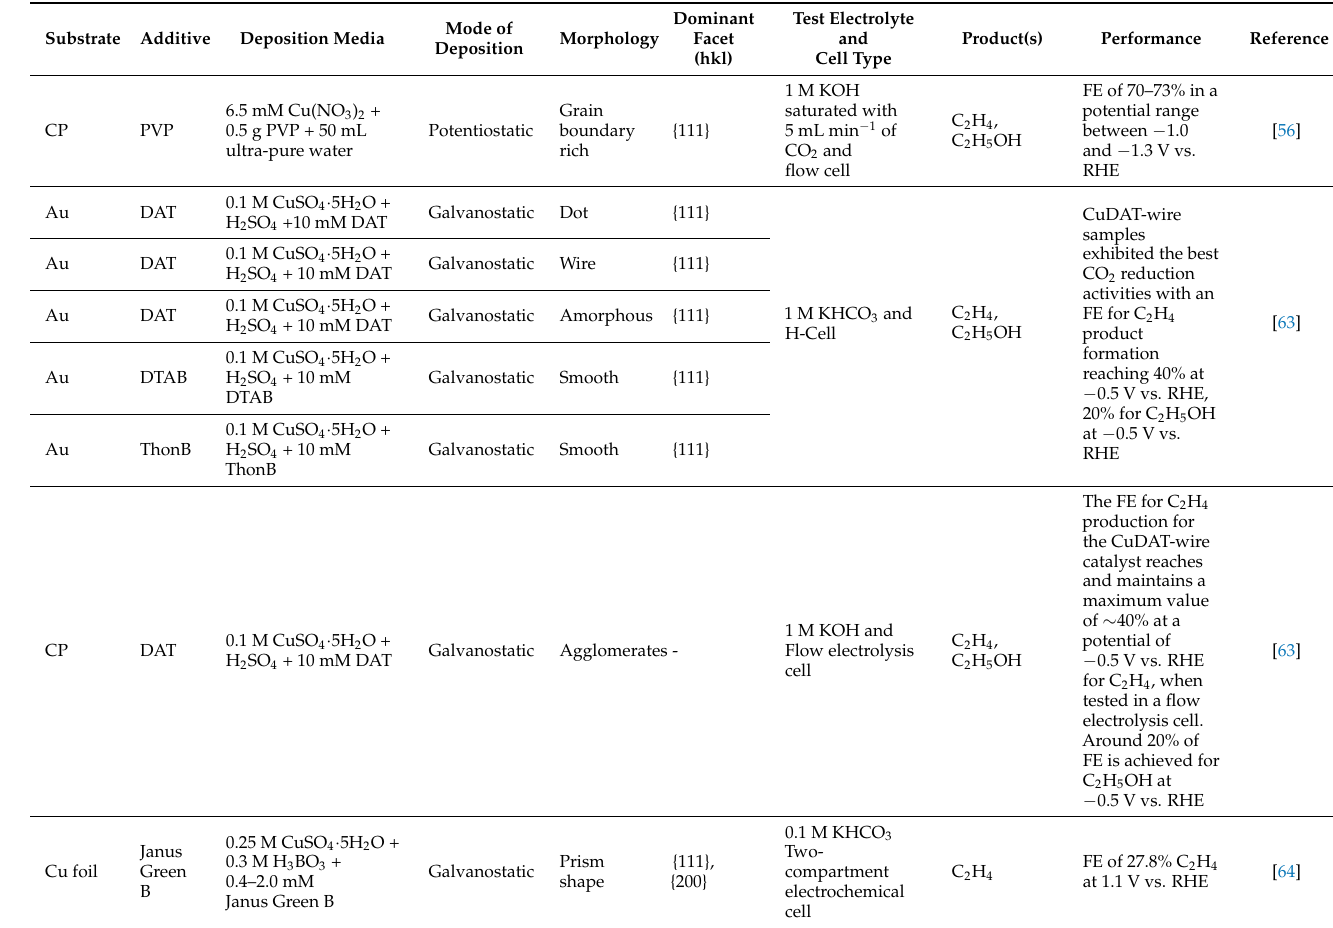
Table 4. Works that reported on the electrodeposition of copper employing different